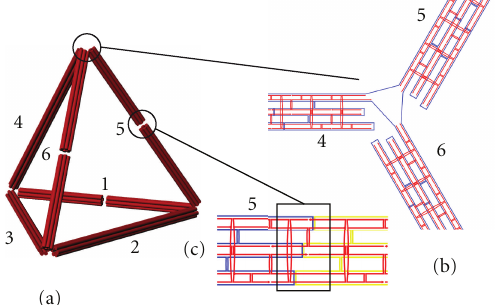
Figure 1: Schematic view of DNA origami tetrahedron. (a) In the three-dimensional representation, each double-helical section is represented by a single red cylinder. The six struts are labeled 1 through 6, and each consist of a bundle of six parallelly connected double helices. (b) A two-dimensional diagram of the hinged vertex formed by struts 4, 5, and 6 shows the path of the m13MP18-based sca ff old (blue) forming the single-stranded connections between bundles and the pattern of staple oligonucleotides (red) around the hinge. (c) Local structure of the sca ff old path within strut 5 shows three closely aligned sca ff old crossovers stabilized by short staple sections forming the weakened gap. The sca ff old path on opposite sides of the gap is marked in either yellow or blue to emphasize the